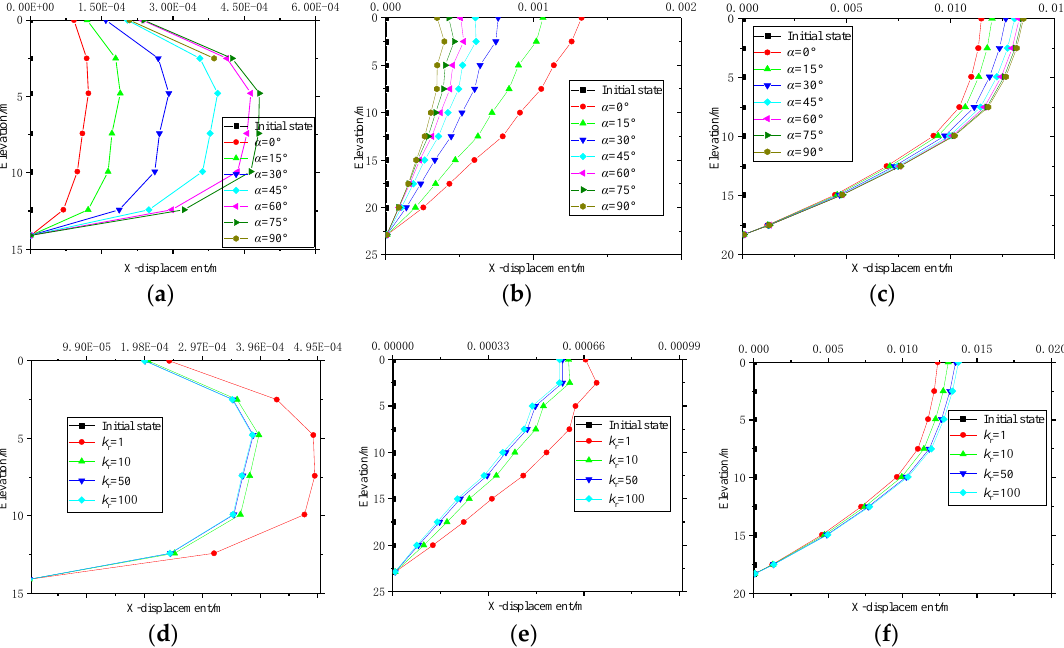
The variations of x -displacement of clay slope top, slope middle and slope toe are shown in Figure 9.